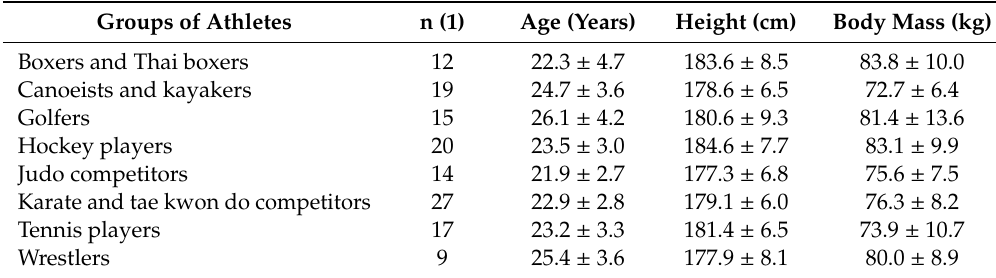
Table 1. Participant’s characteristics (mean ±